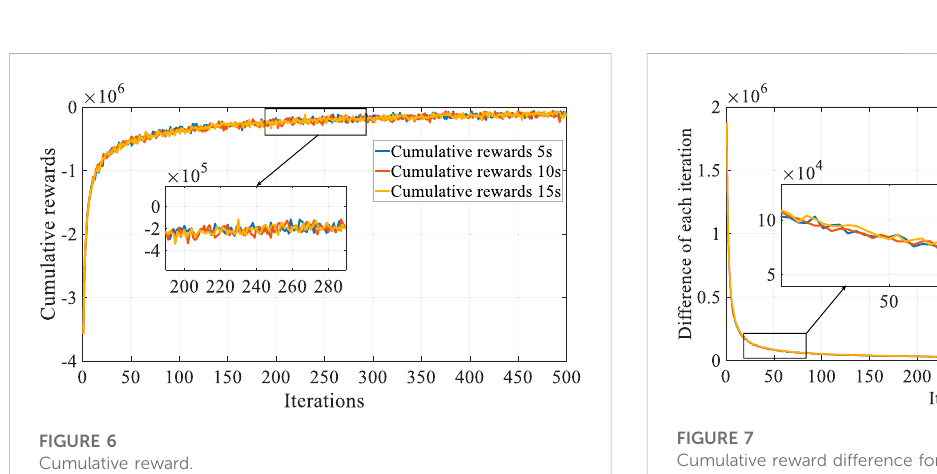
FIGURE 6 Cumulative reward.